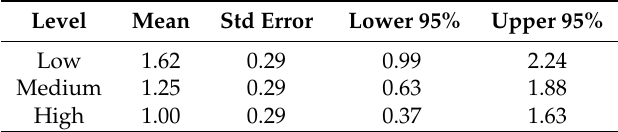
Table 6. The average error in each of the priority regions for the CPs. All units are in